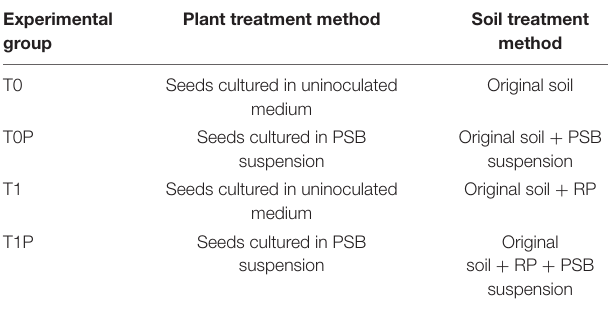
TABLE 2 | Pot experiment treatment for each experimental